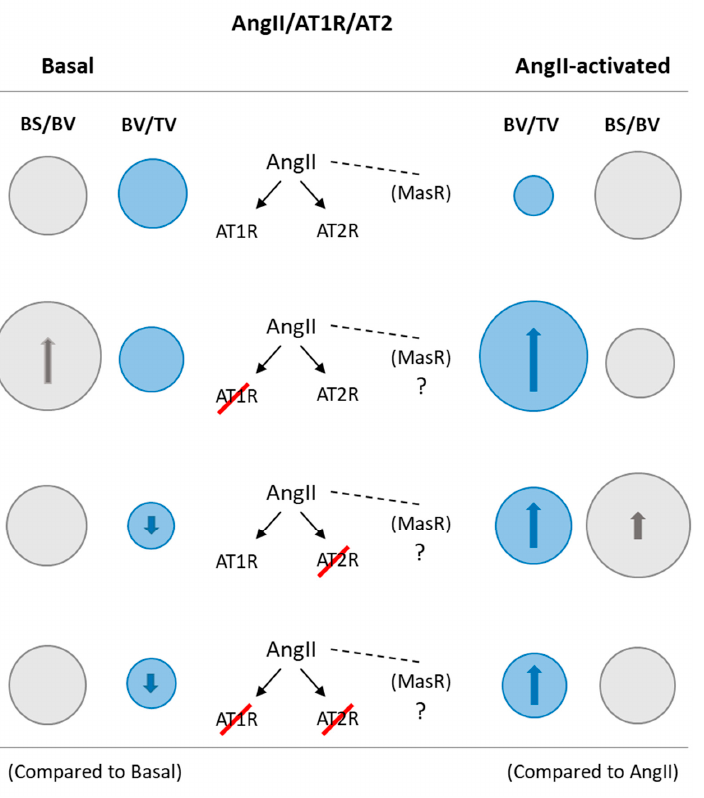
Figure 5. Schematic diagram summarizing the bone responsiveness of ED11 organotypic chick femur model to AngII/AT1R/AT2R axis modulation, for bone volume fraction (BV/TV) and bone surface fraction (BS/BV). Basal: without and with receptor blockade–bone surface fraction in- creased after AT1R blocking and bone volume fraction decreased with AT2R and AT1R + AT2R blockade. AngII-activated: compared to basal conditions, exposure to AngII greatly decreased bone volume fraction, and receptor blockade prior to the addition of AngII prevented the negative ef- fects of this mediator: AT1R blockade resulted in increased bone volume fraction with maintenance of bone surface fraction, whereas, blocking AT2R caused a lower increase on bone volume fraction and a greater bone surface fraction; AT1R + AT2R blockade also led to increased bone volume fraction.